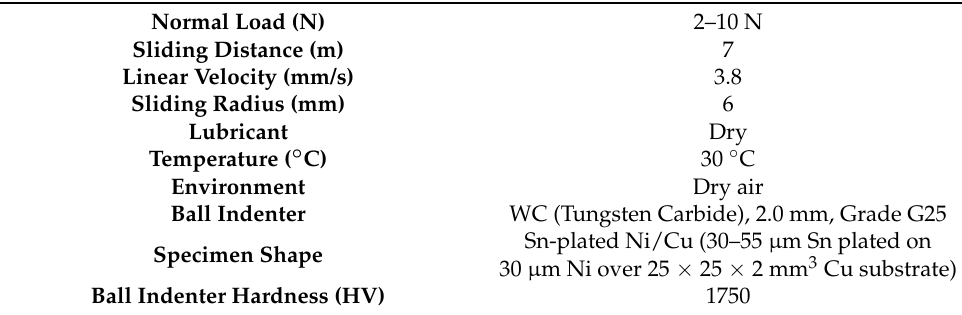
Table 2. Conditions for wear